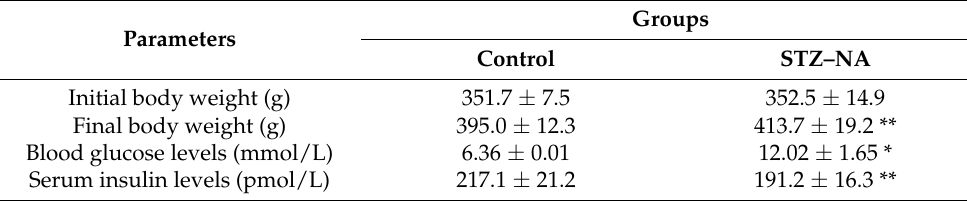
Table 2. Average initial and final body weight, glucose and insulin levels in control (C) and diabetic (STZ–NA)